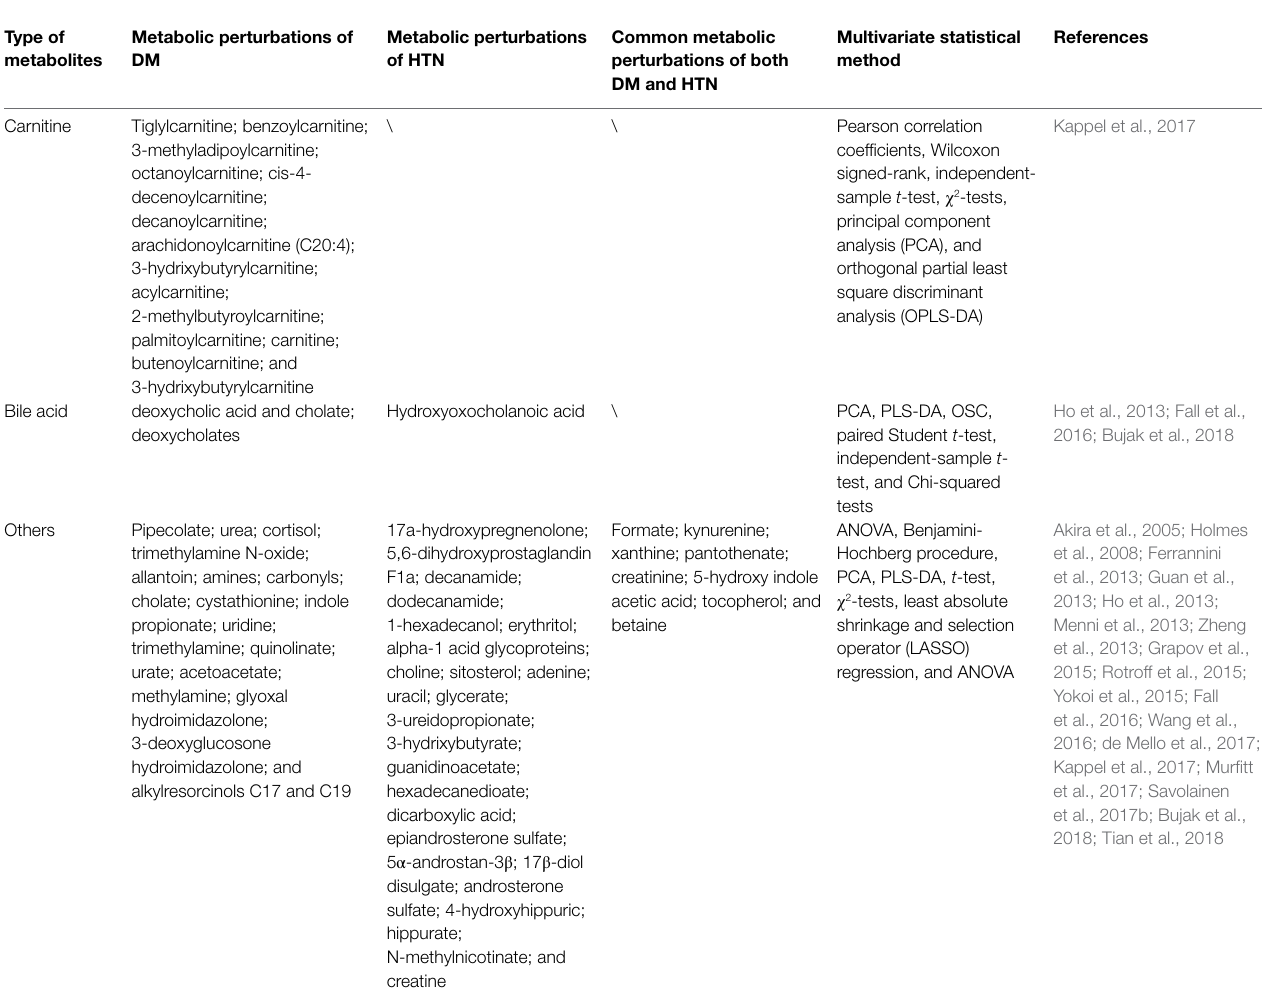
Energy-related metabolites – The gray pie charts represent the ratio of energy-related metabolites in the whole panel of metabolic markers in Figure 1 . The energy metabolism abnormalities are commonly associated with DM and HTN. The two diseases are related to gluconeogenesis, glycolysis, pentose phosphate, and tricarboxylic acid (TCA) cycle (Iemitsu et al., 2003; Ho et al., 2013). Hexose sugars are primarily accounted for by disease-defining increasing glucose and positively associated with DM. And the elevations of fructose, mannose, sorbitol, lactate, and malate have been proved to be associated with DM (Fiehn et al., 2010; Hwang et al., 2010; Menni et al., 2013). α -ketoglutarate, fumarate, and succinate levels in urine are decreased in DM patients (Salek et al., 2007). Lipids and fatty acids – The green pie charts represent the ratio of lipids and fatty acids in the whole panel of metabolic markers in Figure 1 . Given the significance of obesity as one of the risk factors for type 2 DM and HTN, it is not surprising that both DM and HTN patients have increased fat-derived metabolites. Phosphatidylcholine (PC), lysophosphatidylcholine (LPC), phosphatidylethanolamine (PE), and diacylglycerol (DAG) increased the risk of DM (Floegel et al., 2013). Conversely,